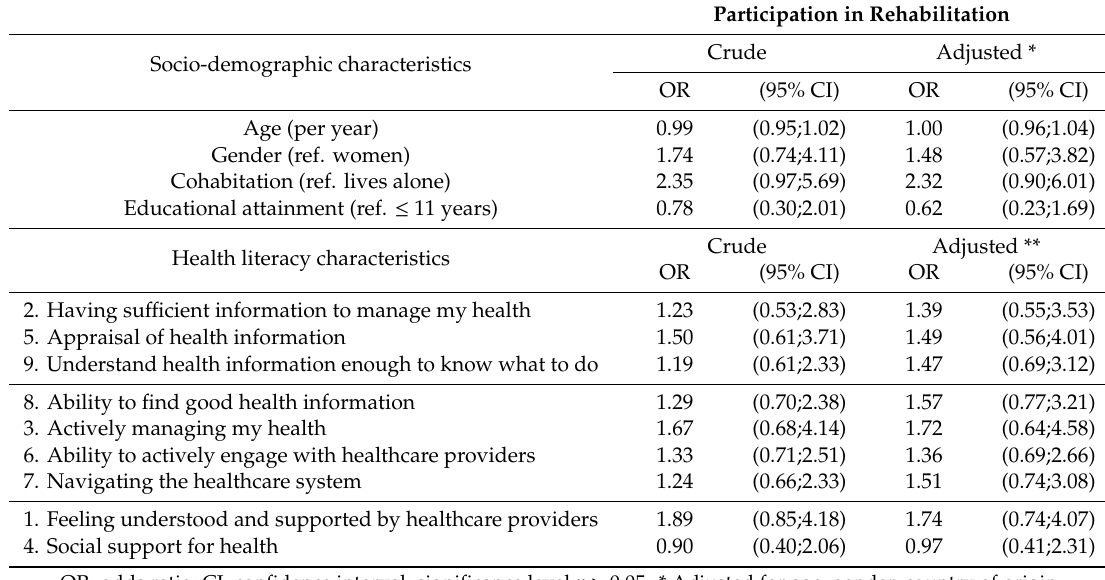
Table 3. Associations between socio-demographic and health literacy measures and rehabilitation participation in the Heart Skills Survey in Randers Municipal Rehabilitation Unit